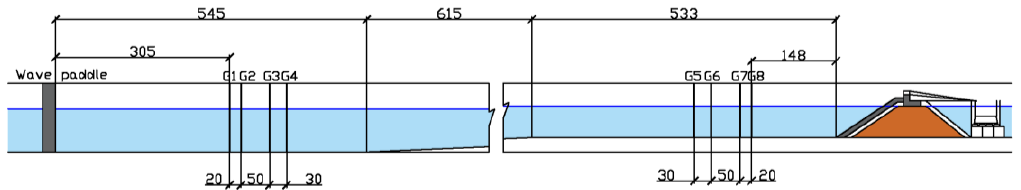
Figure 3. Locations of the pressure sensors in the physical model. Dimensions presented in cm.